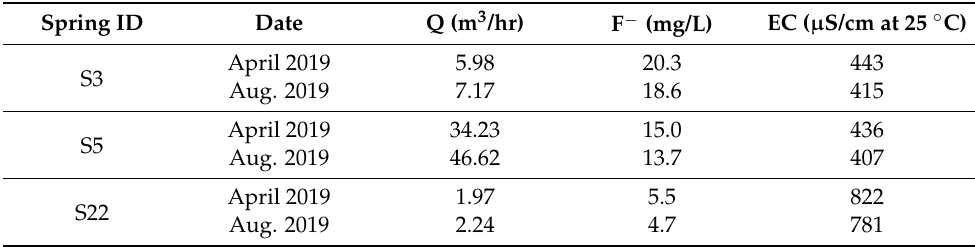
Figure 13. Temporal variability of F ⁻ concentrations in the groundwater samples taken in September 2017 and September 2018. 2017 and September 2018. Table 10. Spring discharges (Q), F ⁻ concentrations, and EC for springs S3 and S5 (at Oldonyo Sambu) Table 10. Spring discharges (Q), F − concentrations, and EC for springs S3 and S5 (at Oldonyo Sambu) and S22 (at Ngaramtoni). and S22 (at